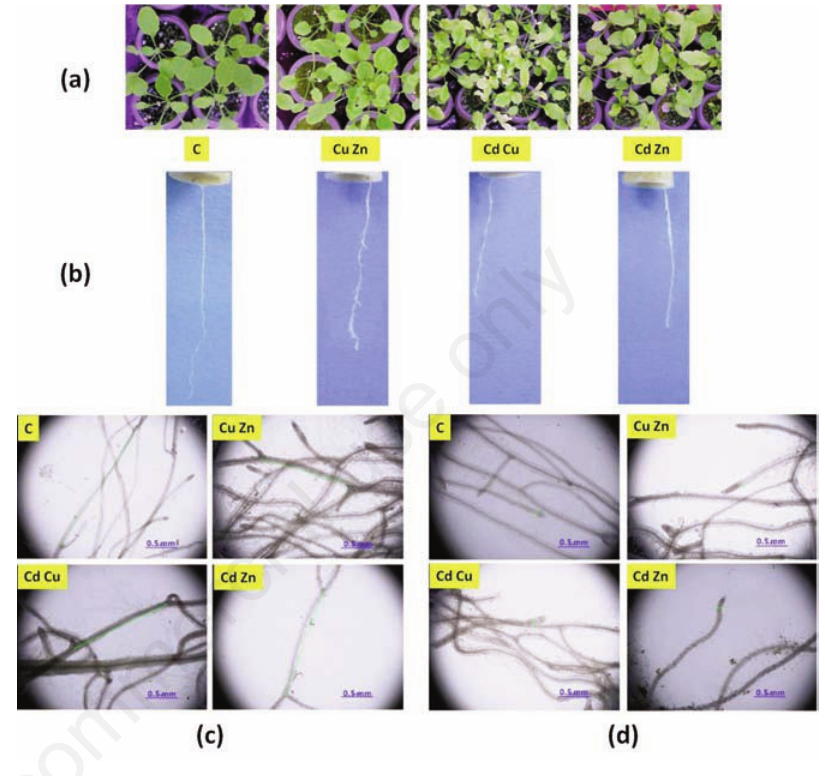
Figure 1. Macroscopic aspect of seedlings (a) and roots (b) of Arabidopsis seedlings not exposed to metals (C; Control) or exposed for 12 days to 5 µM CuSO and 150 µM 4 ZnSO (Cu/Zn), 10 µM CdSO and 5 µM CuSO (Cd/Cu), and 10 µM CdSO and 150 4 4 4 4 µM ZnSO (Cd/Zn). Root morphology (c: branching; d: mean diameter) of the same 4 seedlings. Measured branching and diameters are highlighted with yellow segments. Scale bars = 0.5 mm. Table 2. Concentrations of Cu, Zn and Cd in roots and shoots of Arabidopsis seedlings not exposed to metals (Control), or exposed for 12 days to 5 µM CuSO and 150 µM 4